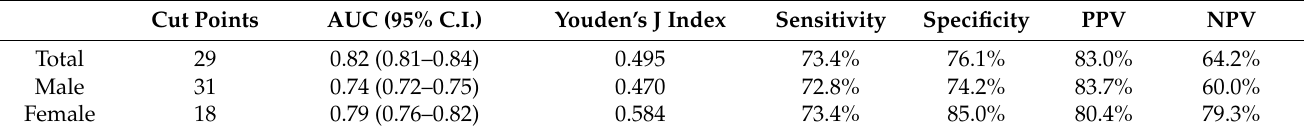
Table 3. Optimal cut-off levels of fatty liver index for predicting ultrasonography-diagnosed NAFLD.